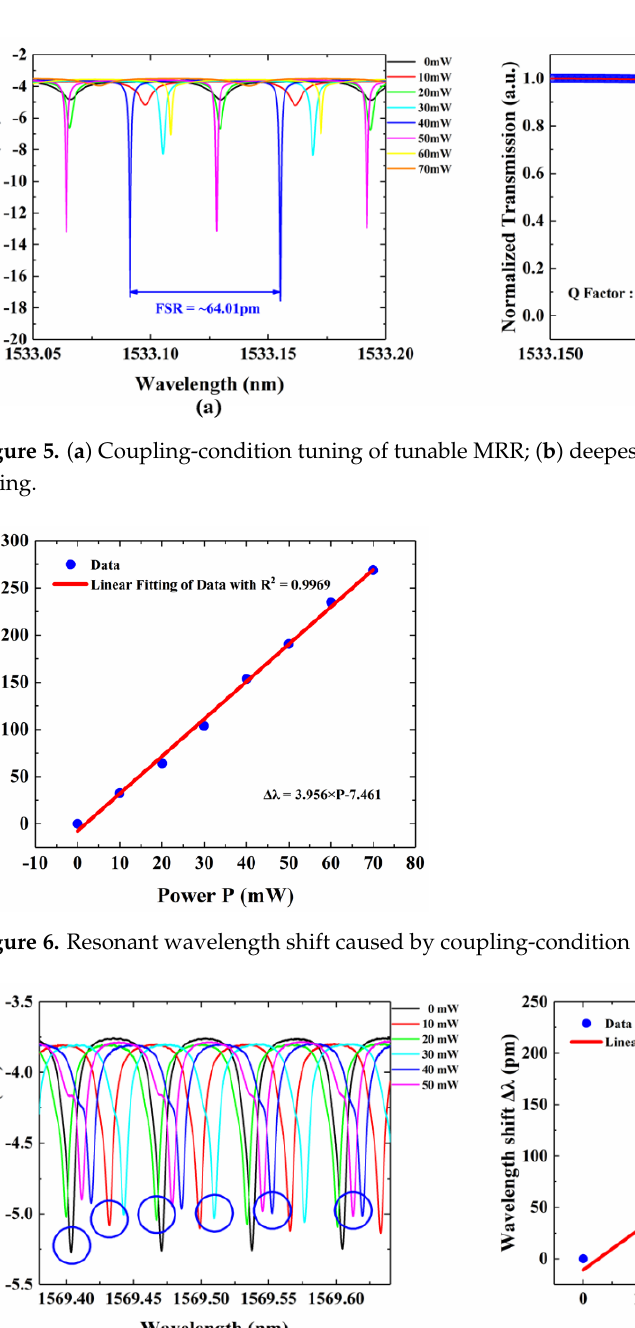
Figure 7. ( a ) Resonant-wavelength tuning of tunable MRR; ( b ) relationship between resonant- wavelength shift and electronic power.